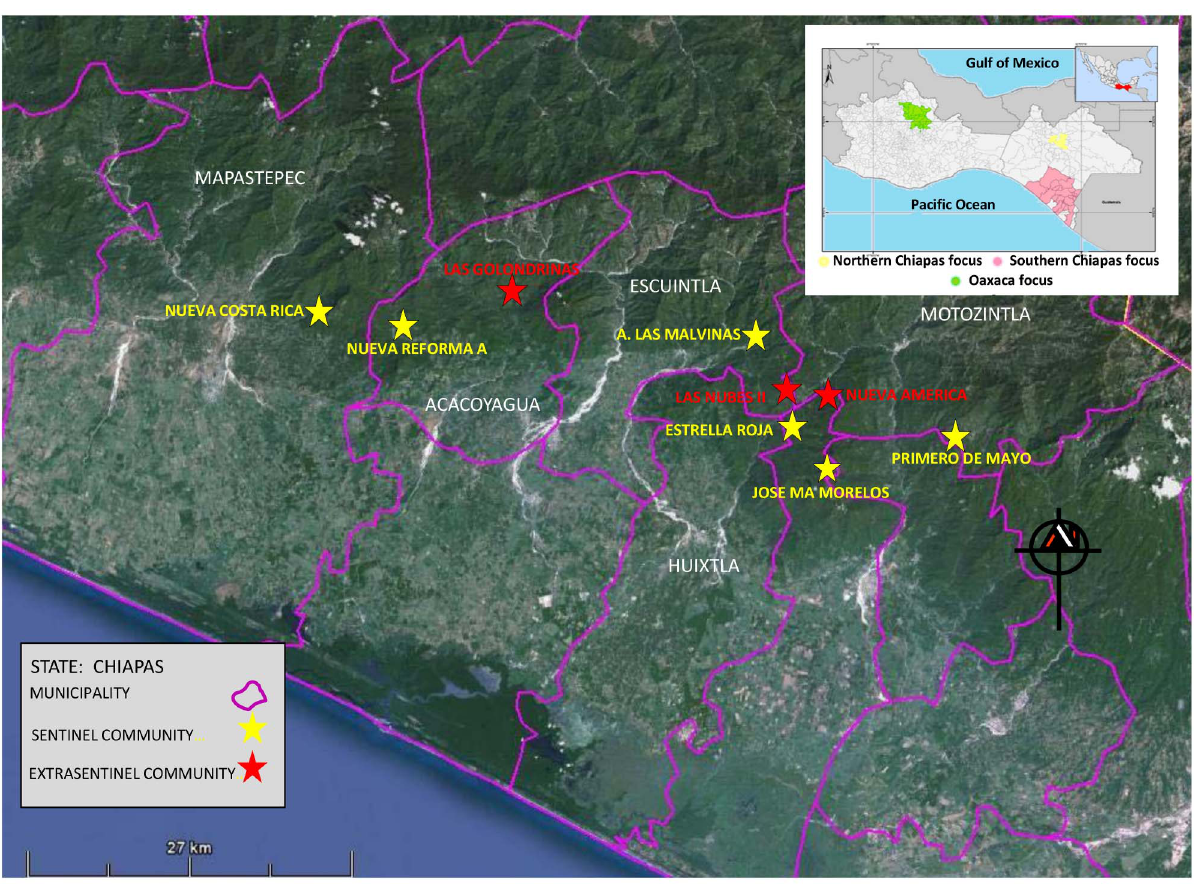
Figure 1. Map of the Southern Chiapas focus, Me´xico. The map of the Southern Chiapas focus shows the six sentinel (marked in yellow) and three extra-sentinel communities (marked in red) and the main rivers and tributaries that might serve as a source of black fly breeding. Map (right) of the Southern Mexico states showing the three onchocerciasis endemic foci. doi:10.1371/journal.pntd.0002133.g001 peak efficiency. The second positive control contained the same minimal amount of positive control DNA mixed with 2.5 m L of a DNA preparation from a fly pool that tested negative in a prior set